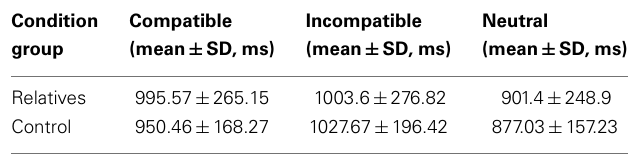
Table 5 |ACE-RTs .